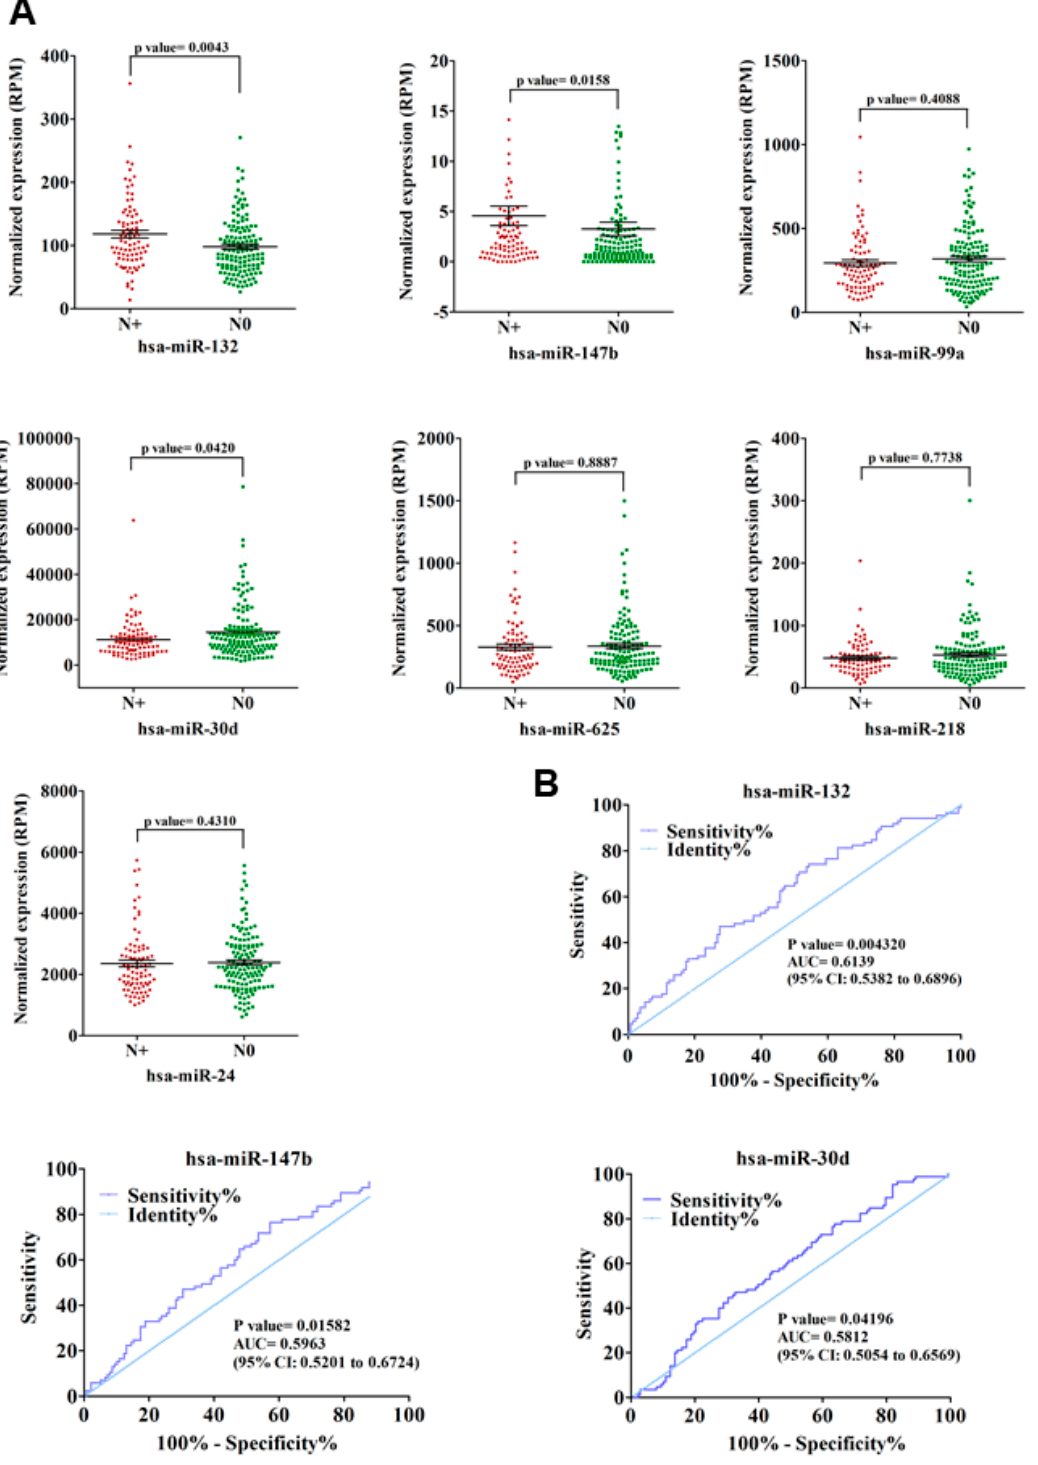
Figure 5. Mutant p53 R273H -regulated miRNAs predict lymph node metastasis (LNM) in lung adenocarcinoma patients. ( A ) Relative expression of seven mutant p53-regulated miRNAs in lymph node positive (N + , n = 85) and lymph node negative (N 0 , n = 138) patients. Scatter plots showing normalized expression (RPM) of individual miRNAs in N + and N 0 group of patients. p -values are indicated. ( B ) Receiver operating characteristic (ROC) curve analyses for LNM prediction in lung adenocarcinoma patients using relative expression of miR-132, miR-147b, and miR-30d. Area under the receiver operating characteristic curve (AUC) is shown. p -values are indicated.